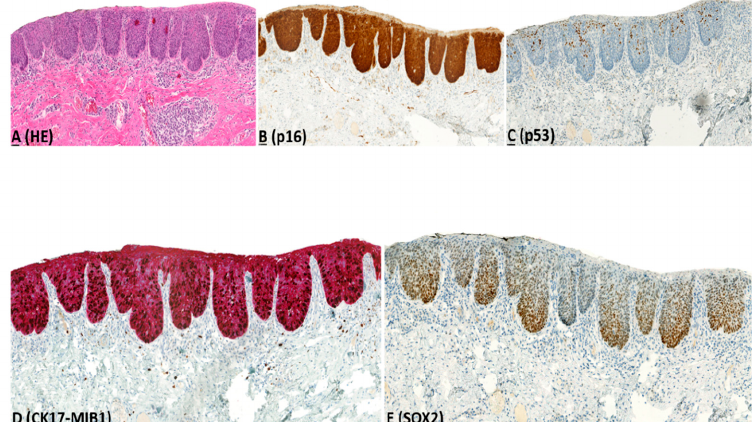
Figure 4. Example of immunohistochemical expression of p16, p53, CK17-MIB1, and SOX2 in high grade squamous intraepithelial lesion (HSIL); ( A ) Histological appearance of HSIL (HE-stain); ( B ) block-type p16-expression; ( C ) wild-type (mid-epithelial) p53-expression; ( D ) diffuse, strong CK17-expression across full epithelial thickness and increased MIB1-expression; ( E ) diffuse, strong SOX2-expression across full epithelial thickness.